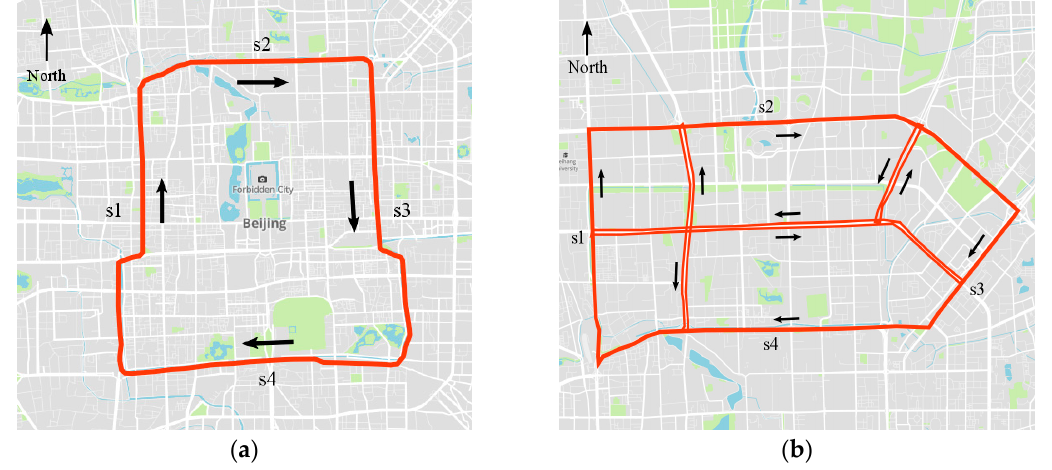
Figure 3. Two sub-transportation networks for testing: ( a ) Network 1, the second ring of Beijing; and ( b ) Network 2, a network in Northeast Beijing